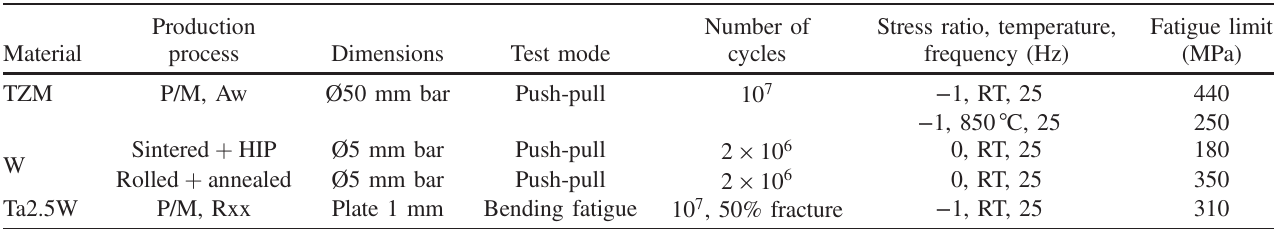
TABLE V. Summary of the reviewed high-cycle fatigue data relevant for the BDF target operational conditions. Sources: TZM